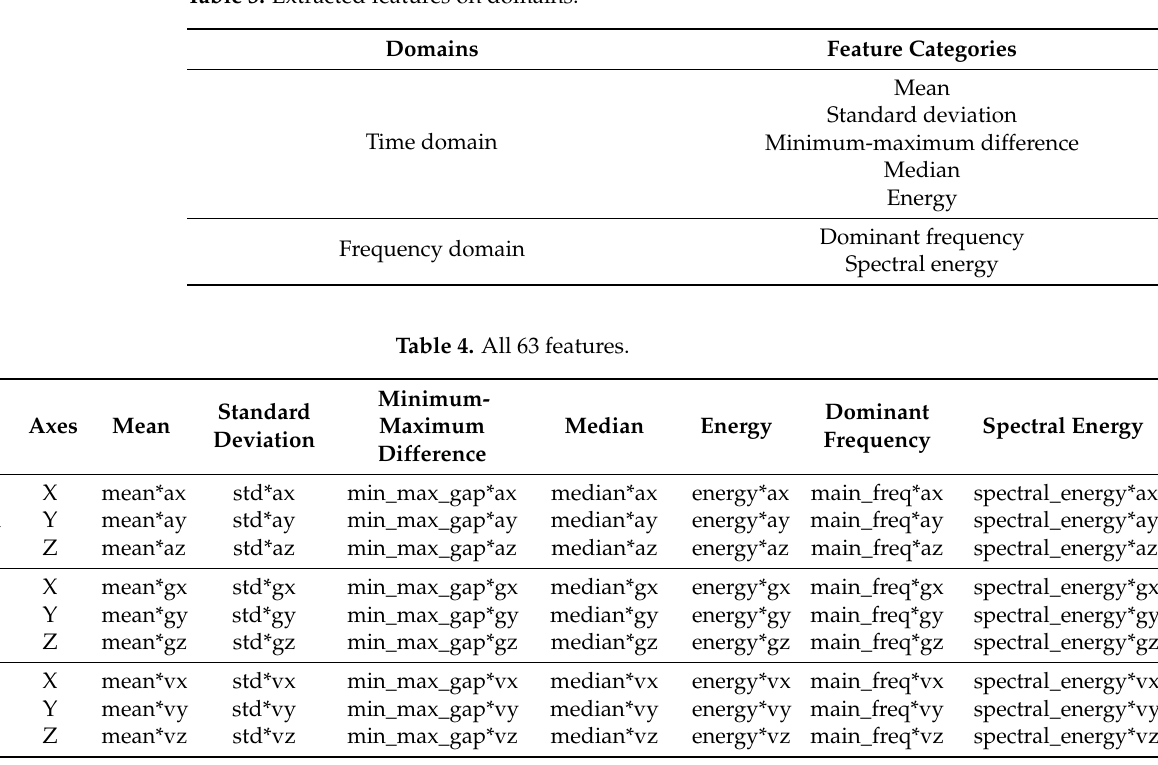
Table 3. Extracted features on domains.